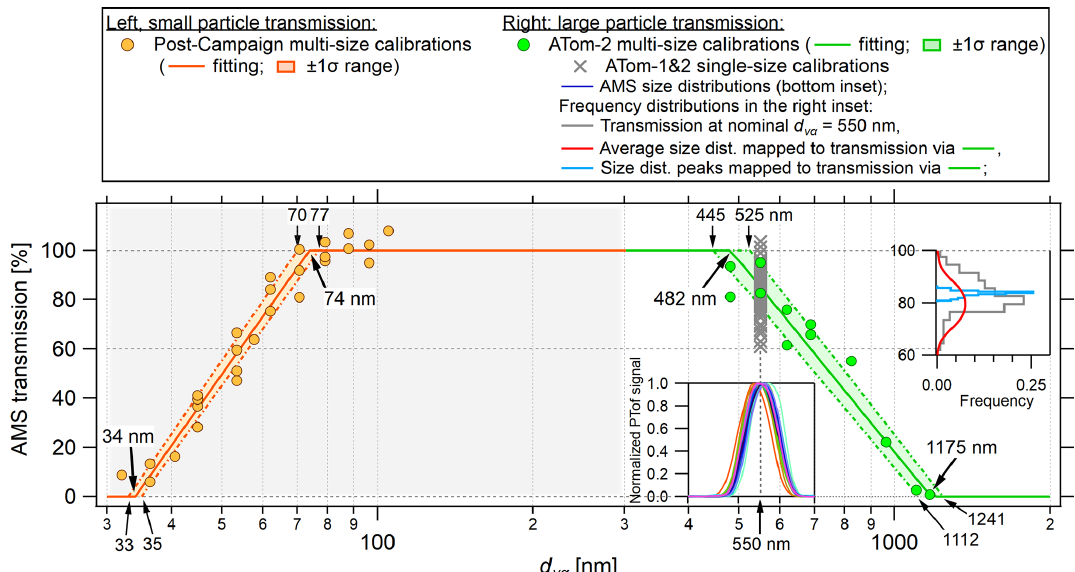
Figure 2. Results of AMS transmission calibrations vs. vacuum aerodynamic diameter ( d va ) for ATom-1 and ATom-2. The small particle transmission was calibrated with oleic acid post-campaign (left), and the large particle transmission was calibrated with NH 4 NO 3 particles in the field. On the right side, the green markers are multi-size field calibrations, and the gray cross markers are single-size (at d m = 400nm, equivalent to 550nm d va ) field calibrations after every research flight. The insets show the frequency distributions of measured transmissions (right, top) and observed, normalized size distributions (left, bottom) of these single-size calibrations. A fit shows 100% transmission at 483nm (1 σ uncertainty of the fit: 445–525nm) and 0% transmission at 1175nm (1 σ : 1112–1241nm). When forcing 0% transmission at 1175nm (confirmed by ( NH 4 ) 2 SO 4 calibrations), the fit to all data gives 100% transmission at 482nm (1 σ : 479–485nm, not shown), consistent with the 483nm fitted values based only on the ATom-2 multi-size field